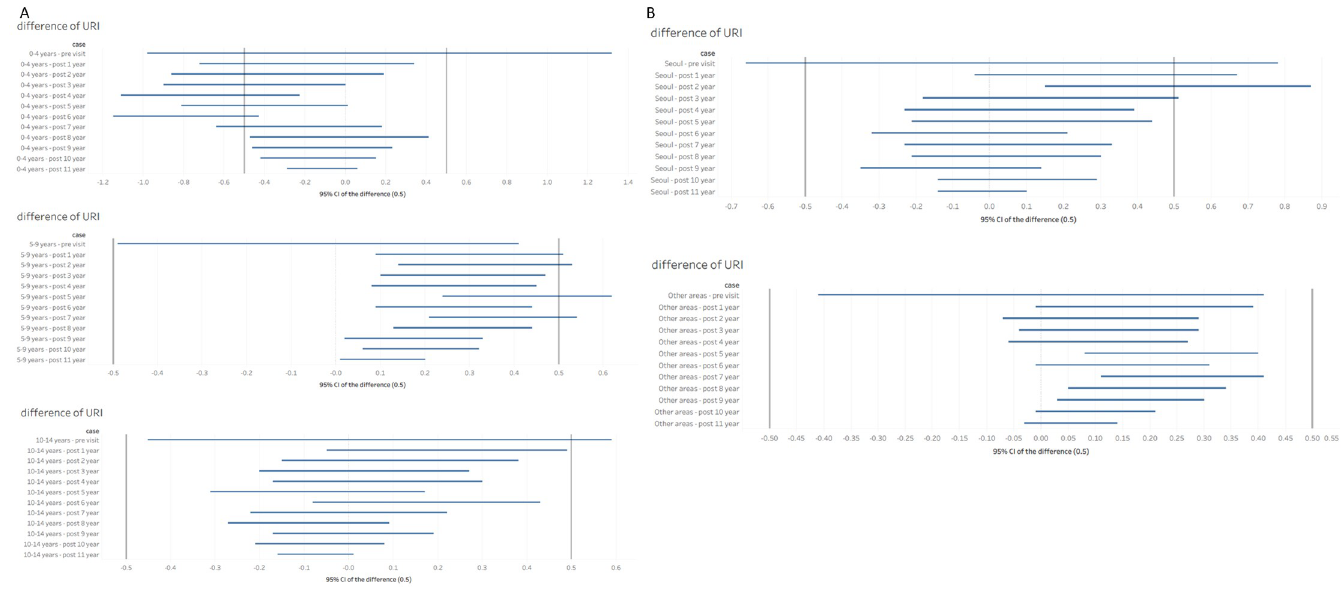
Fig 3. Differences in the mean values for pre- and post-operative upper respiratory infection according to (A) age or (B) residence.